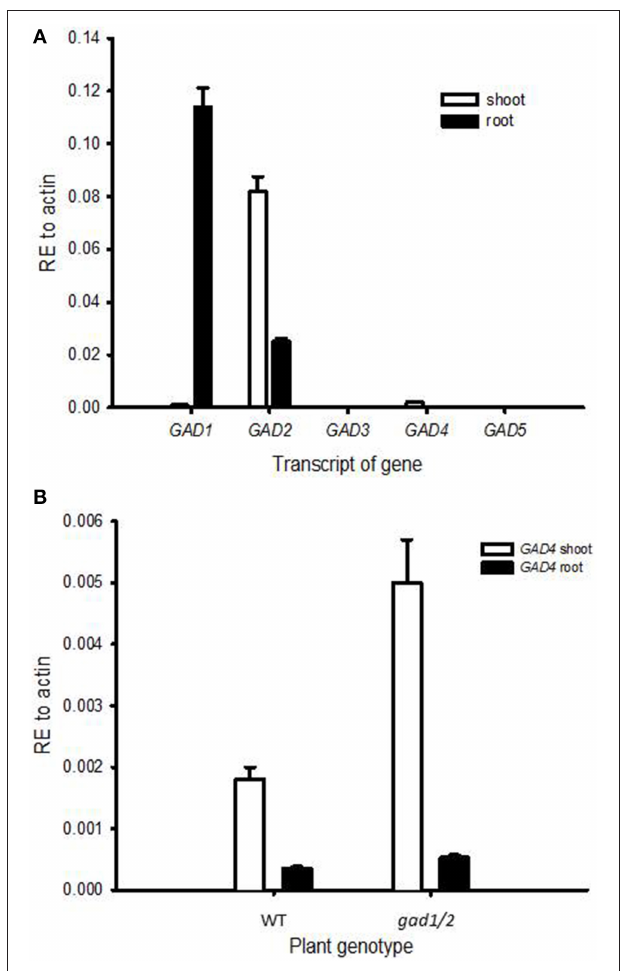
FIGURE 1 | Expression analysis of GAD genes in Arabidopsis shoots and roots. Plants of 5-week-old wild-type (A) and 4-week-old wild-type and gad1/2 mutant (B) were used. GAD3 and GAD5 transcripts were not detectable. Values are means of three biological replicates. Error bars represent the standard error of means; RE, relative